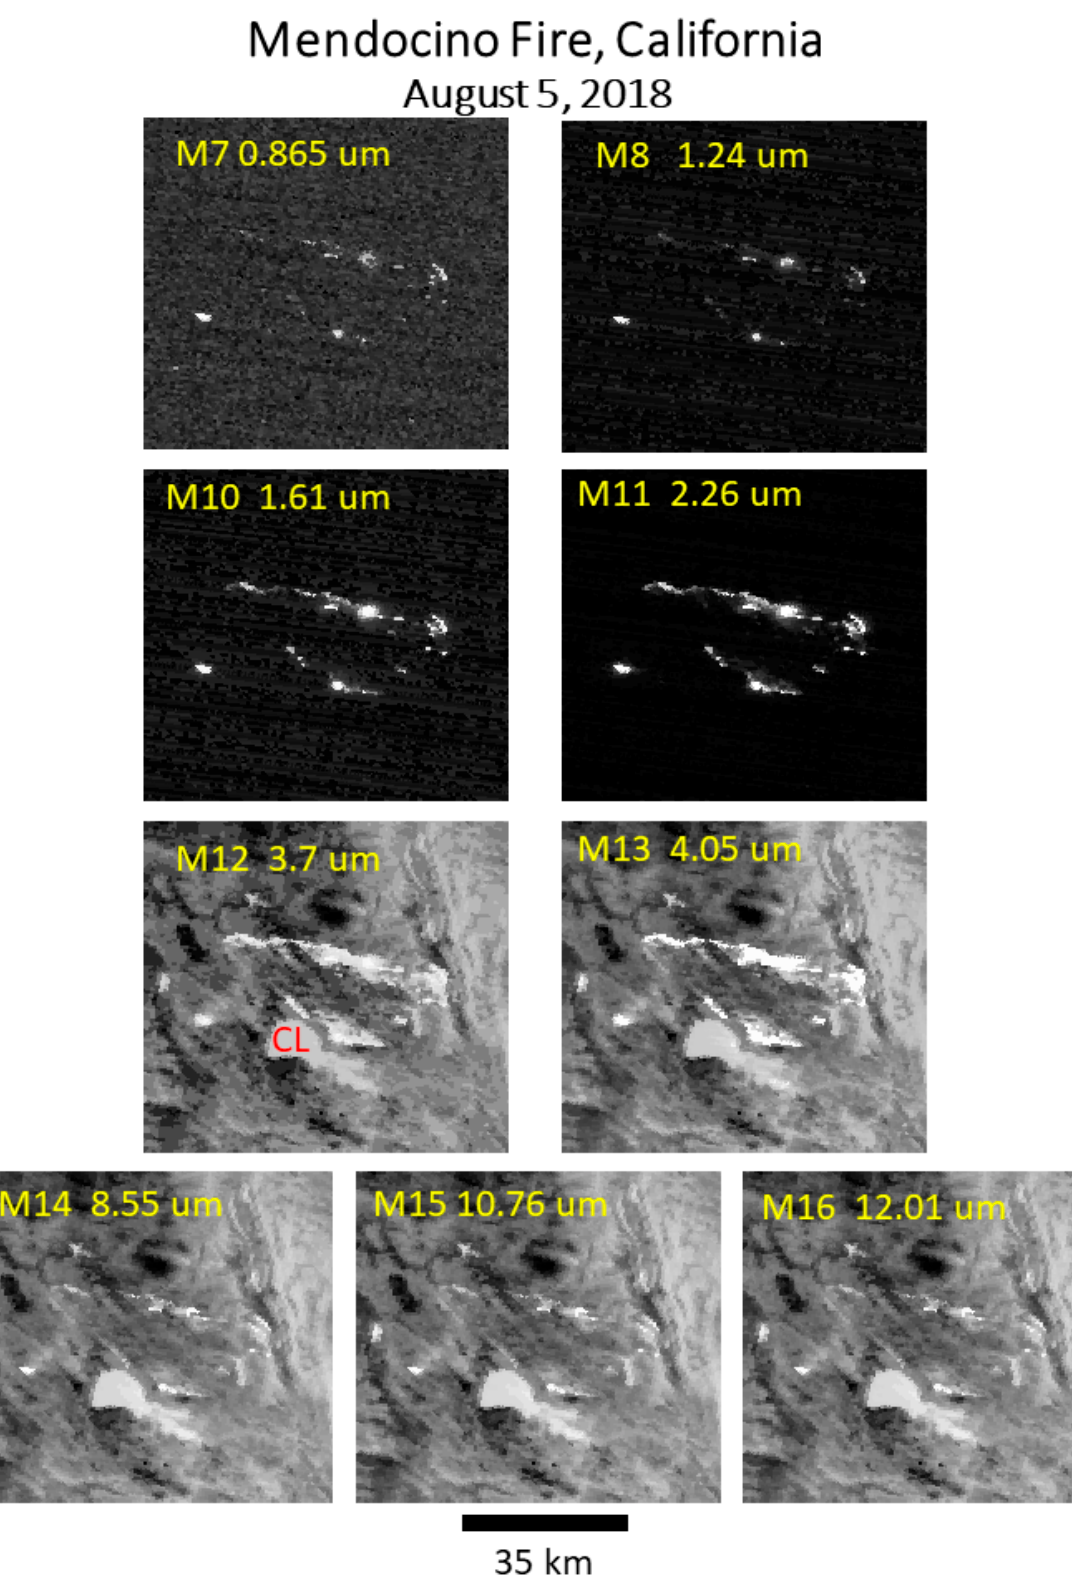
Figure 5. The Mendocino fire study area. The fire is north and east of Clear Lake, which is marked with the letters “CL” on the M12 image.